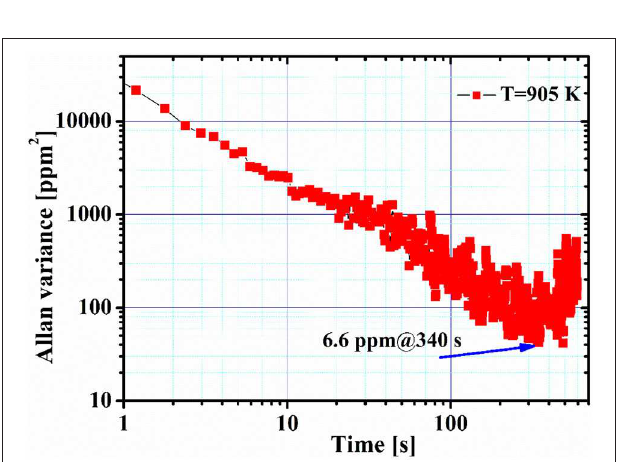
FIGURE 7 | Allan-Werle variance plot obtained from continuous time series measurements.